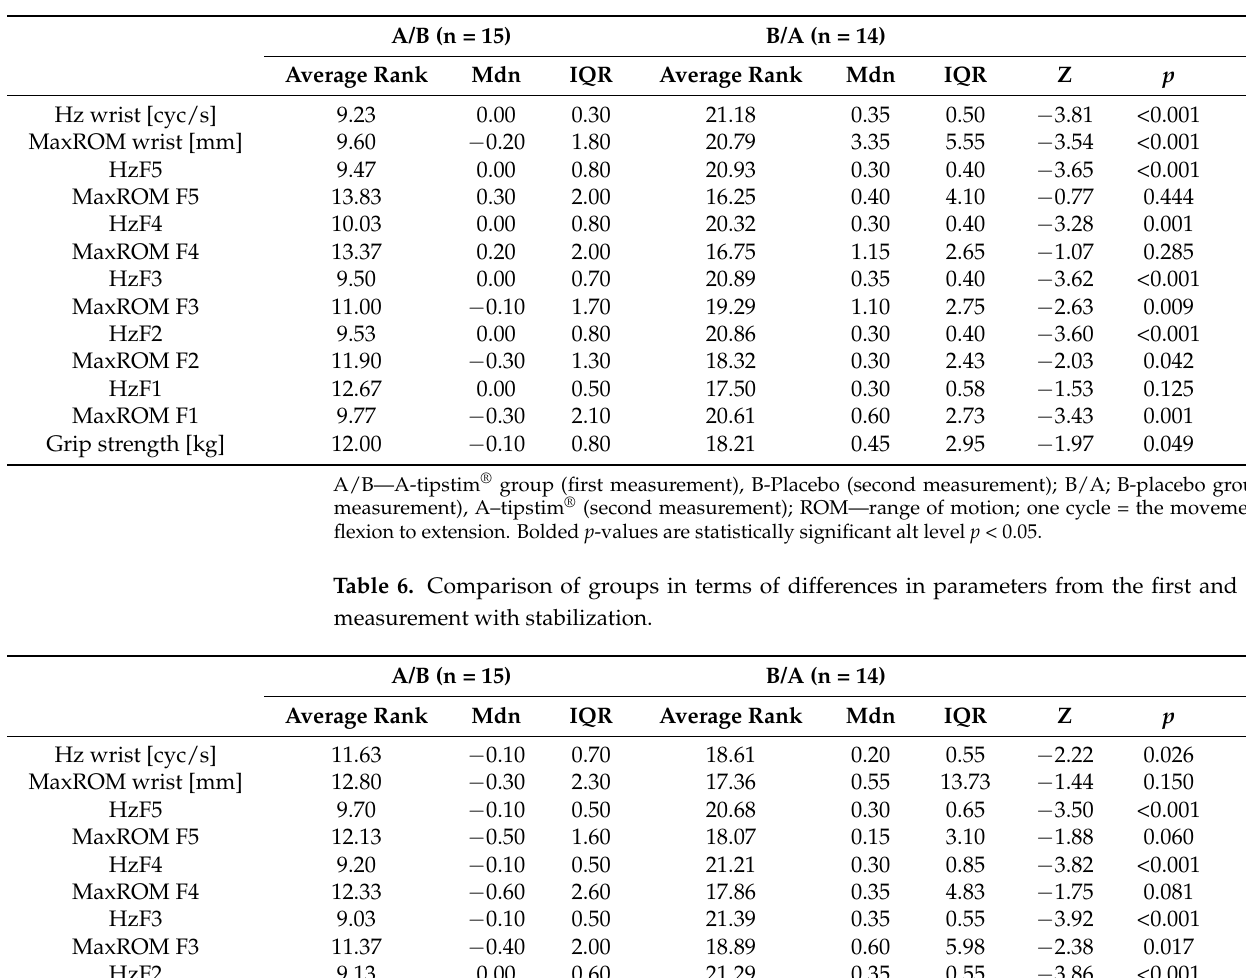
Table 5. Comparison of groups in terms of parameter differences from the first and second measure- ment without stabilization.